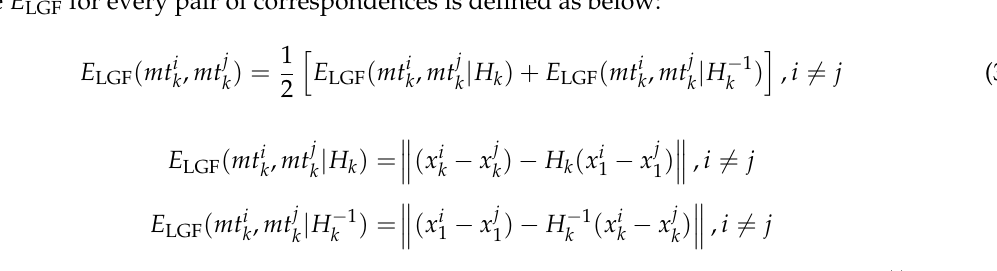
Figure 3. Forward-backward pairwise dissimilarity measure E LGF between correspondence mt i mt j (green solid lines). The dashed red and blue points are transformed by the homography H k and k the inversion of homography H − 1 k